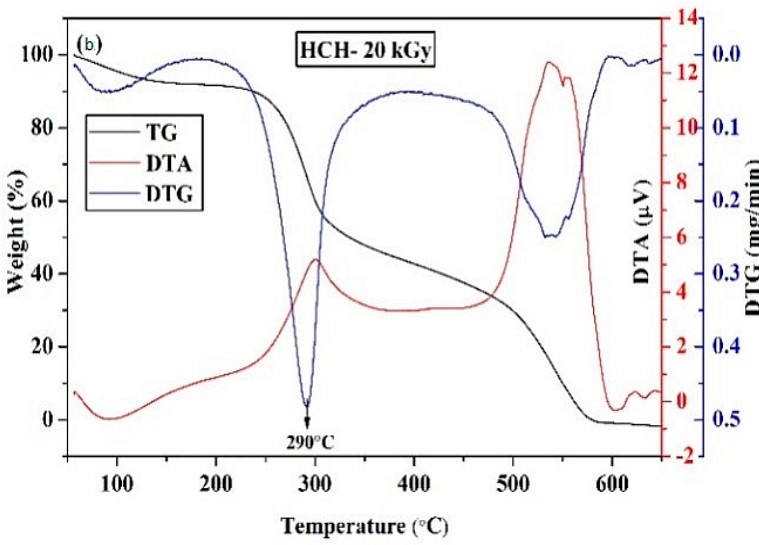
Figure 4. Thermogravimetry (TG), DTG, and differential thermal analysis (DTA) curves of irradiated chitosan: ( a )HCH-10 kGy and ( b ) HCH-20 kGy.